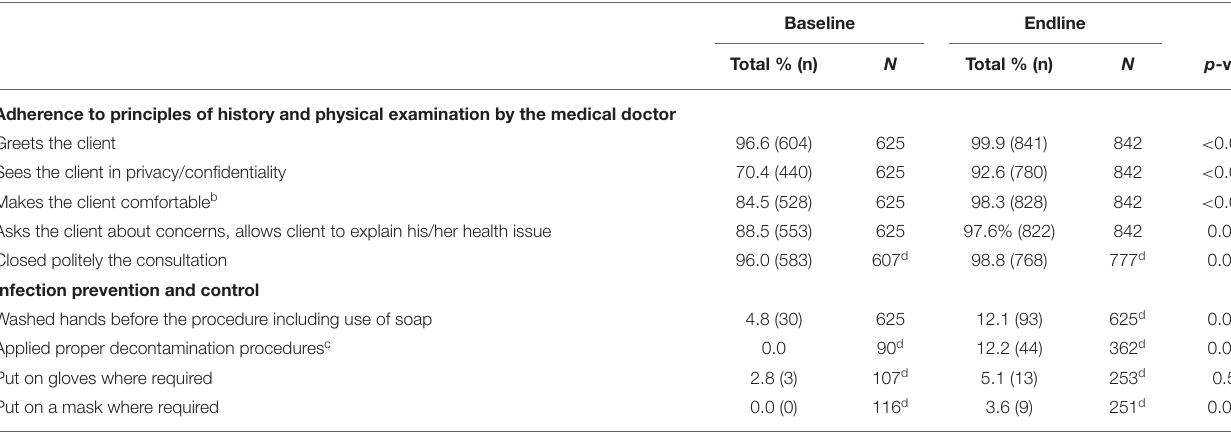
TABLE 2 | Rating for adherence to the principles of history and physical examination by the medical doctor and for infection prevention and control.